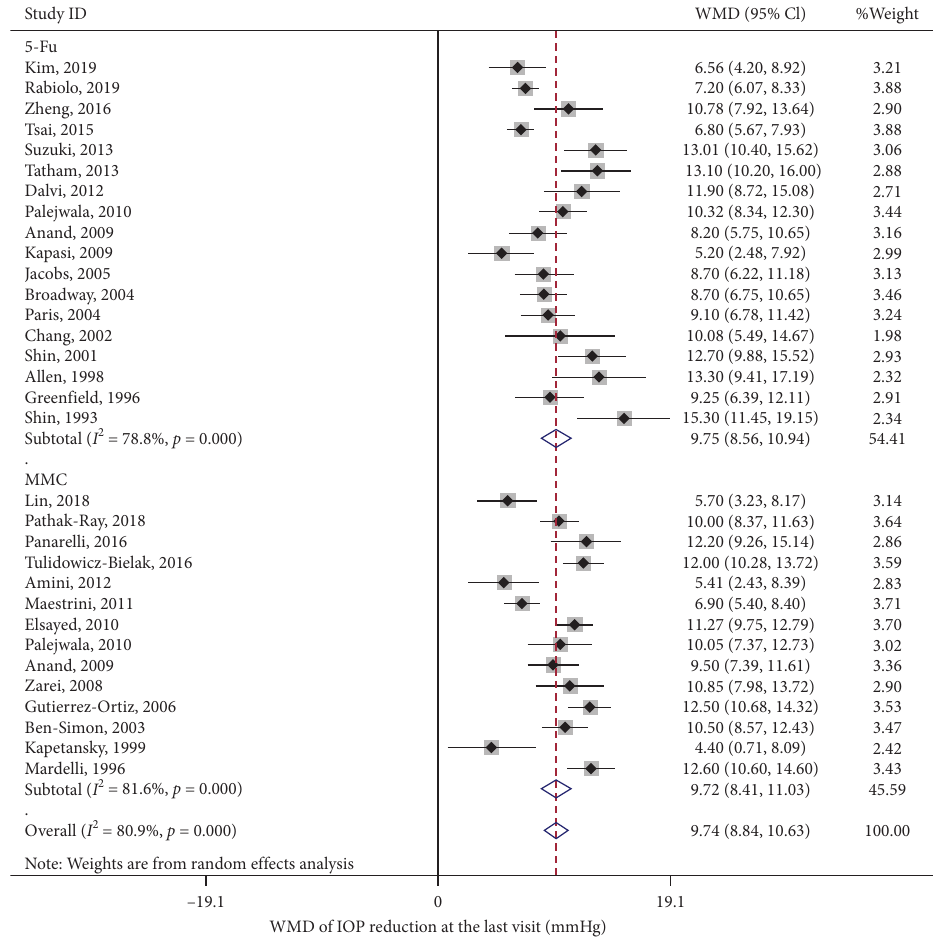
Figure 4: Weighted mean difference (WMD) of reduction in intraocular pressure (IOP) from baseline to the last visit. Subgroup analysis displayed the MMC and 5-Fu was used as an augmentation in bleb needling surgery.